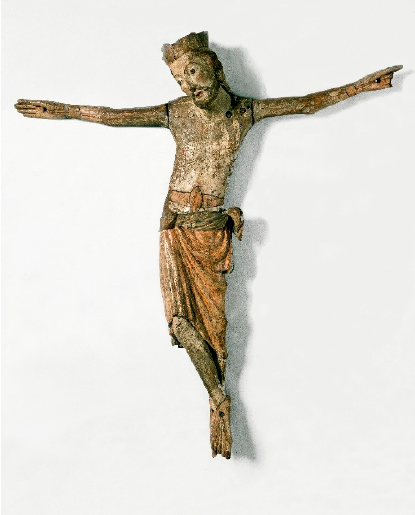
Figure 3. Crucifix from Dal. Polychrome oak. Polychrome oak, 1225–50. Oslo, Museum of Cultural History, Inv. No. C6130. Photo: Eirik Irgens Johnsen (CC BY-SA 4.0).